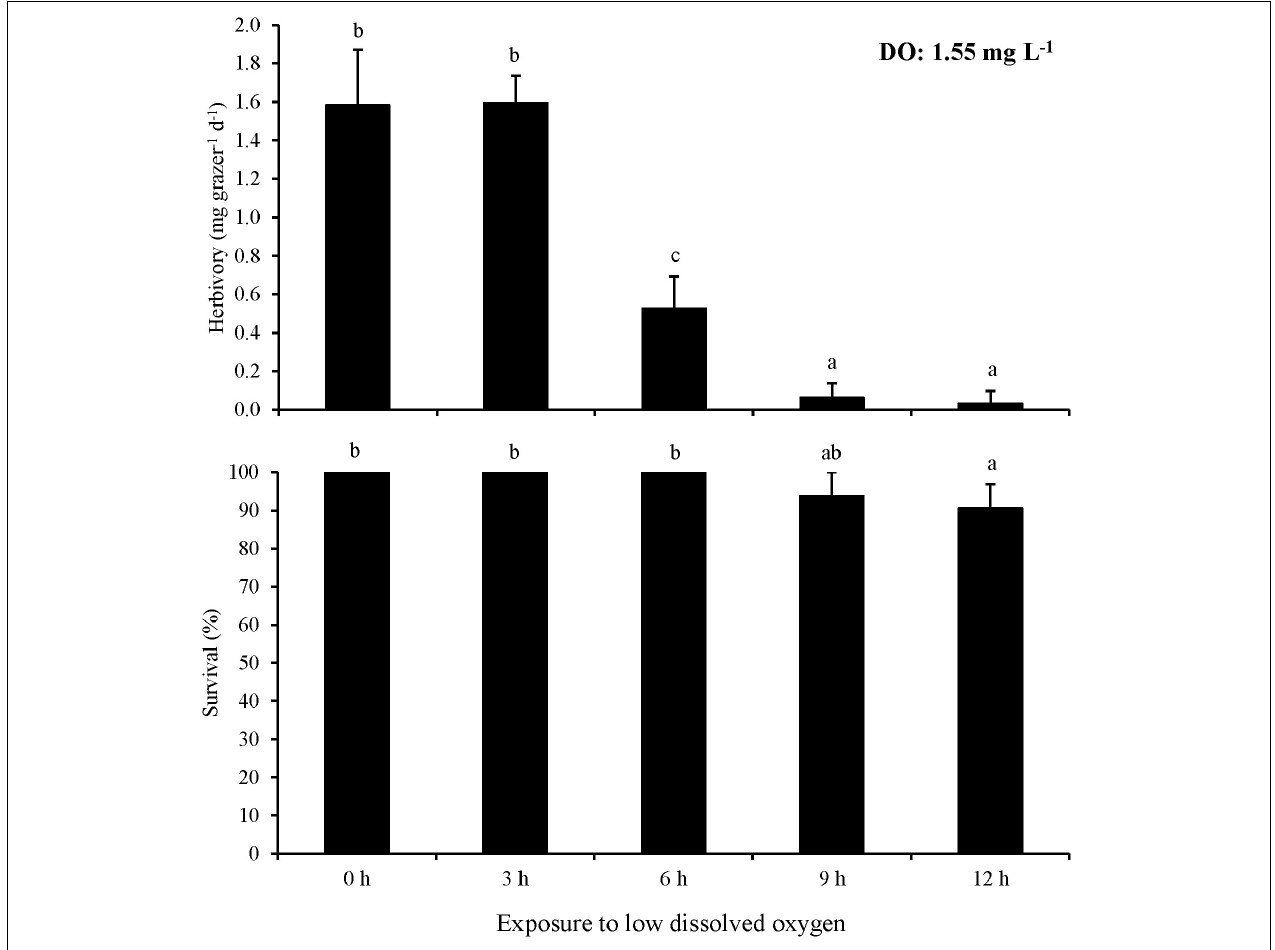
FIGURE 7 | Herbivory rates of L. vincta initially starved for 24 h under ambient pH/DO and allowed to graze on U . rigida for 12 h with varying durations of exposure (0 – 12 h) to low DO concentrations (1.55 mg L − 1 ) (Experiment 7; Table 2 ). Statistical analyses: One-way ANOVA and post-hoc Tukey Honest Significant Difference tests performed; significant differences between treatments represent p -values less than 0.05.